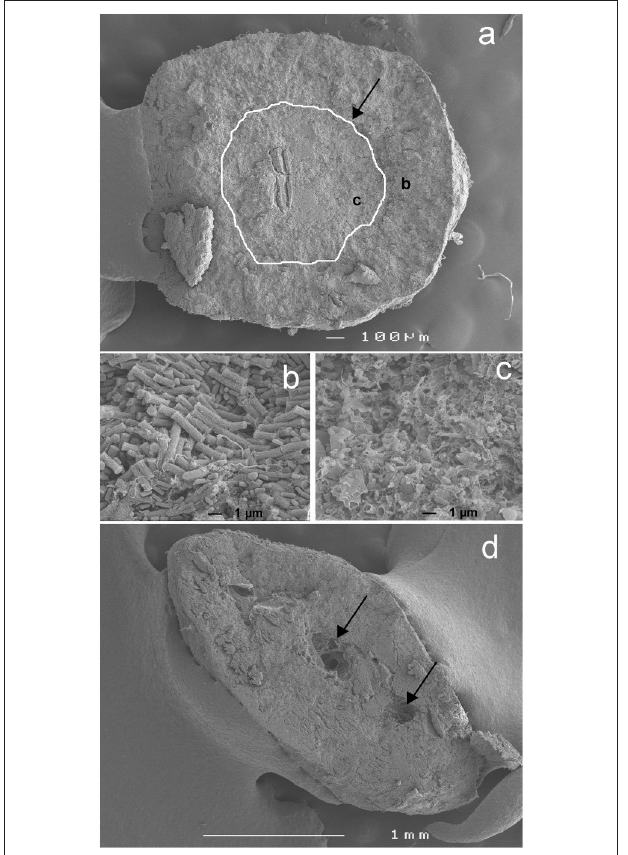
FIGURE 2 | Scanning Electron Microscopy (SEM) pictures of a typical methanogenic granule investigated. (A) A cross section of a single granule with the border between the core and the outer layer highlighted (white curve and black arrow) and the position of the detailed pictures [letters (B) and (C) ] indicated, (B) detail of the microbial population in the outer layer and (C) in the core and (D) a cross section of another granule (embedded in glue during SEM acquisition) with occurrence of cracks indicated by the black arrows.